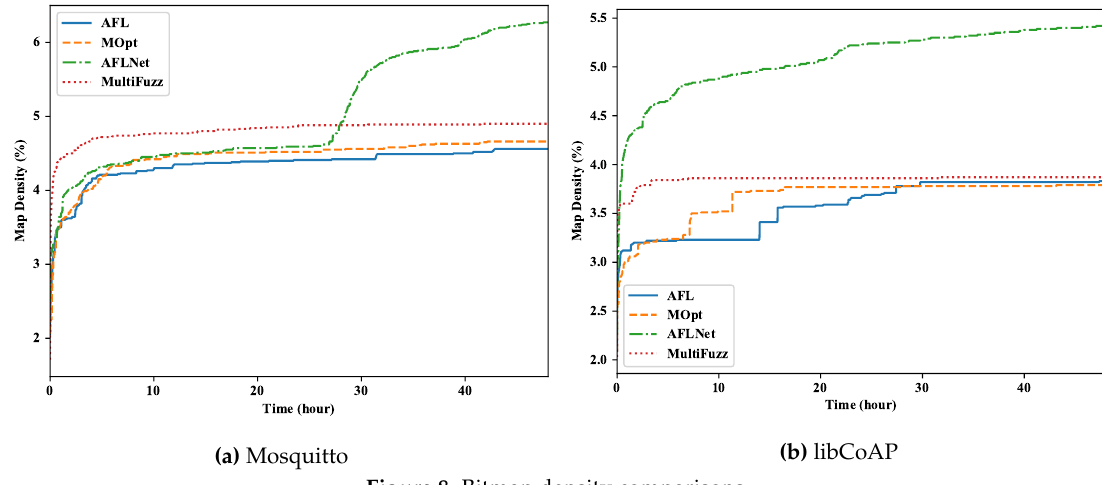
Figure 8. Bitmap density